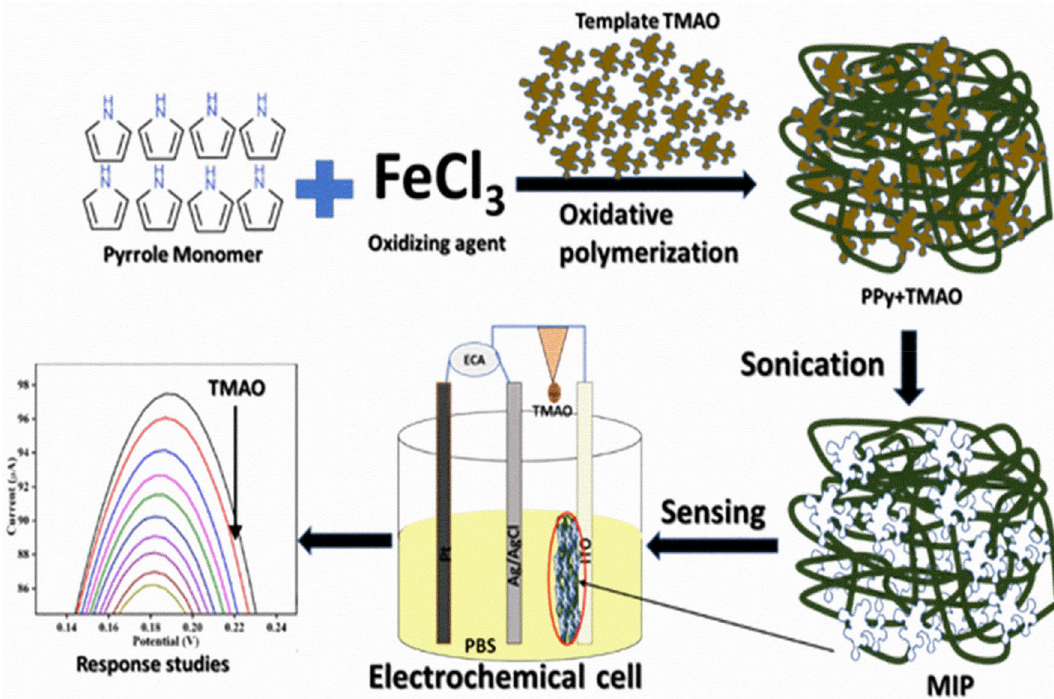
Figure 6. Schematic representation of the MIP synthesis and the fabrication of MIP/ITO electrode towards TMAO detection. The interracial oxidative polymerization was employed for the synthesis of the TMAO imprinted polypyrrole (PPy). MIP/ITO electrode were fabricated by deposition of MIP onto ITO surface electrophoretically, which is further used as a working electrode towards detection of TMAO. The image